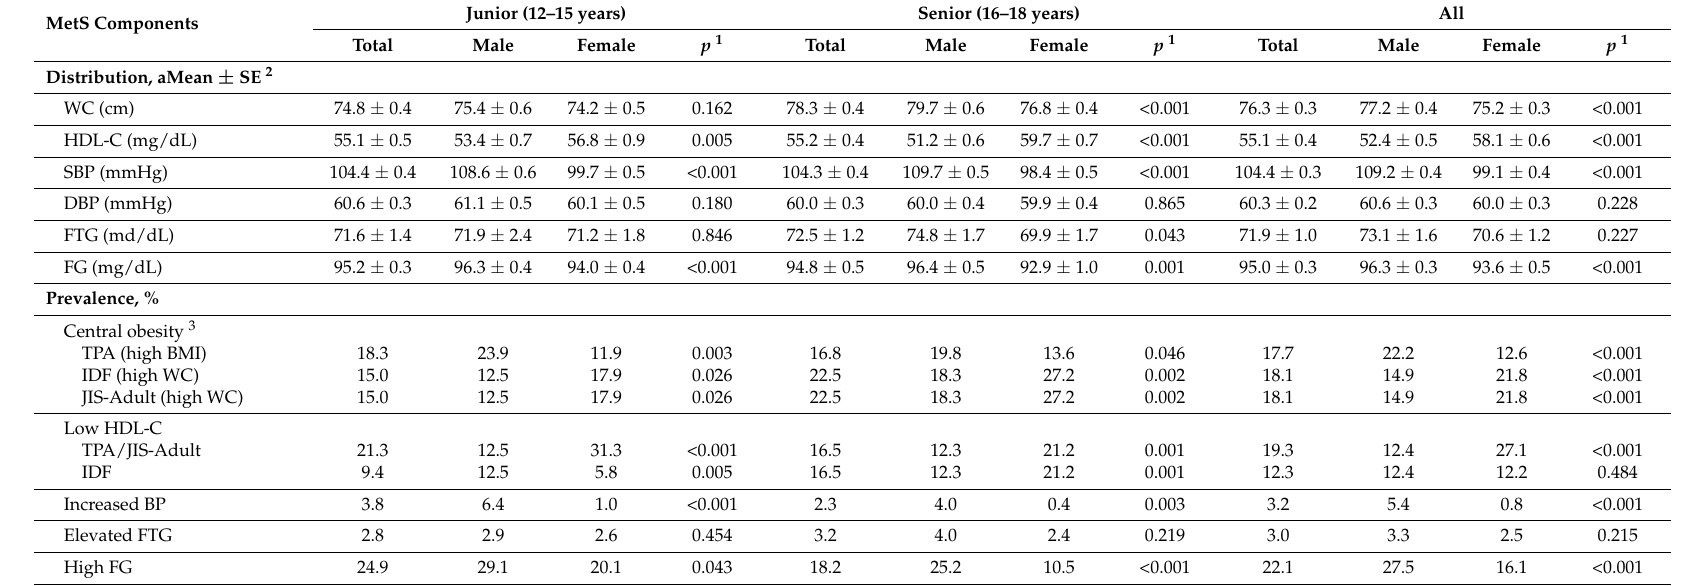
Table 2. Distributions and prevalence of MetS risk components defined by TPA and IDF adolescent criteria and JIS-Adult criteria in adolescents,